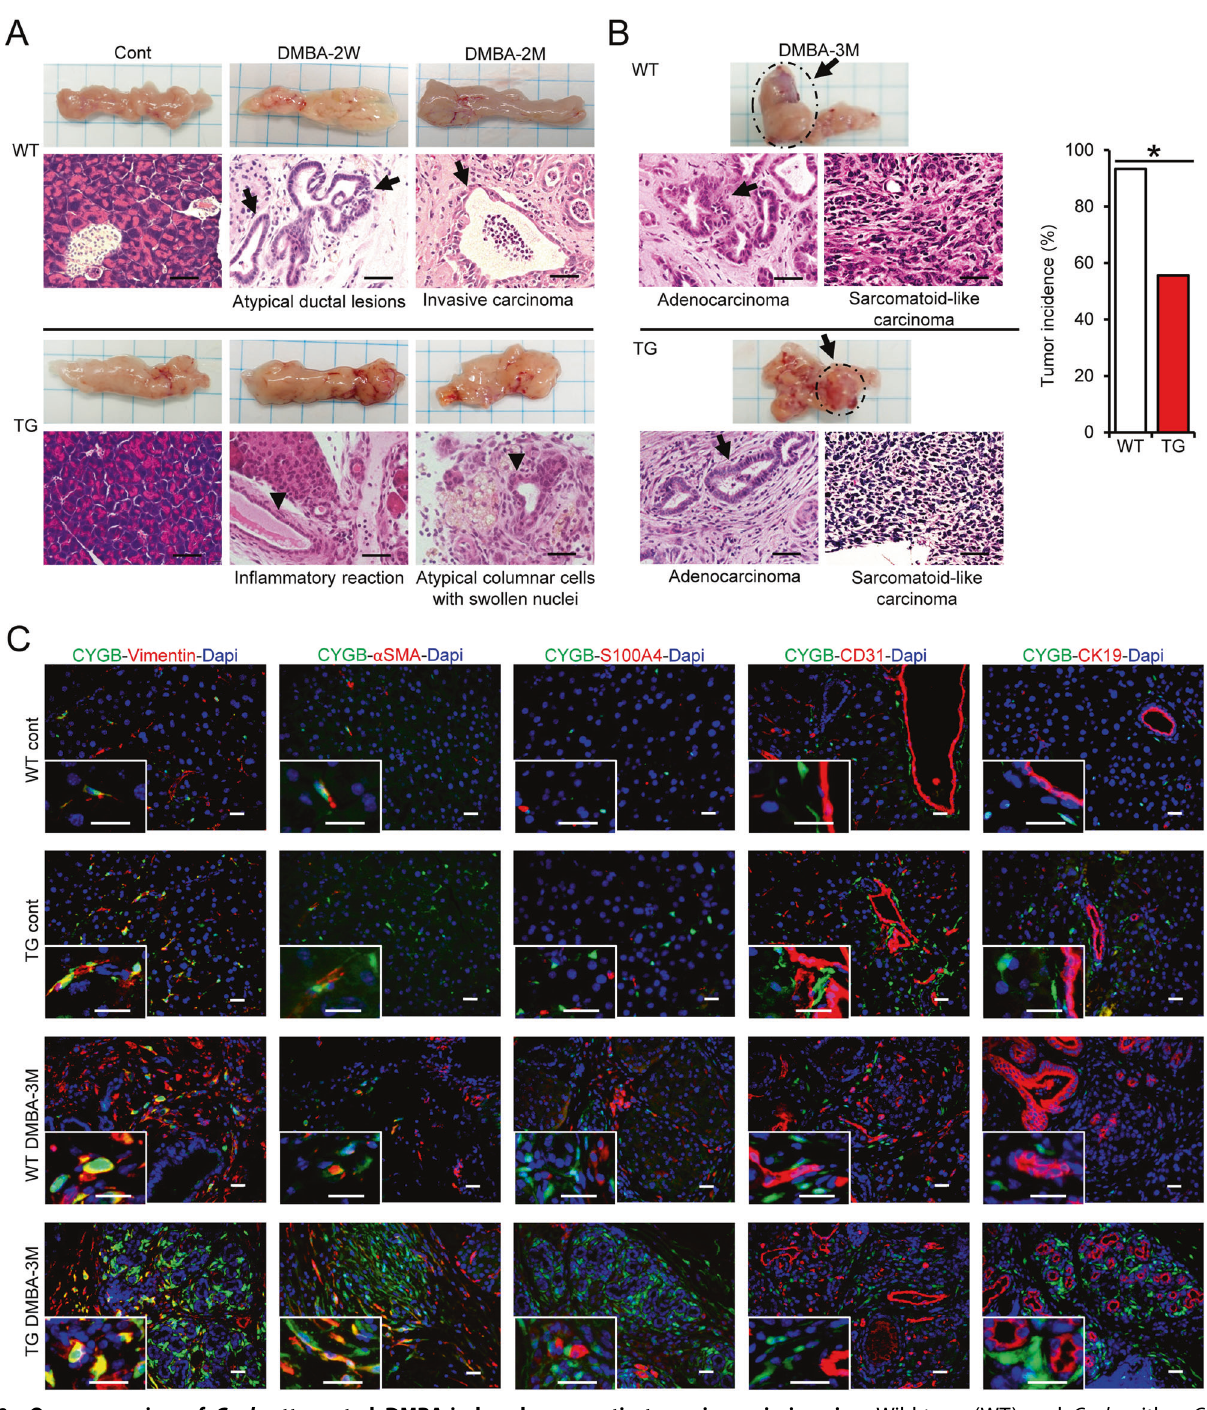
Fig. 2 Overexpression of Cygb attenuated DMBA-induced pancreatic tumorigenesis in mice. Wild-type (WT) and Cygb with mCherry reporter-overexpressing (TG) mice were under placebo (cont) or DMBA treatment at different time-points. A Representative pancreatic macroscopic and microscopic H&E staining images. N = 3 in control groups and n = 8 in DMBA treatment groups. Scale bars, 20 µm. B Representative pancreatic macroscopic and microscopic H&E staining images in 3-month DMBA-treated mice and their tumor incidence. N = 15 in WT group and n = 9 in TG groups Scale bars, 20 µm. * p < 0.05, Fisher ’ s exact test, two-tailed. C Double immuno fl uorescent staining for CYGB (green) and markers for PSCs (Vimentin), activated PSCs ( α SMA), fi broblasts (S100A4), endothelial cells (CD31), and pancreatic ductal cells (CK19) in mouse pancreatic tissues. Dapi was used to visualize nuclei. Scale bars and inset, 20 µm. model. The number of CD68-positive macrophages in pancreatic Attenuation of DMBA-induced pancreatic in fl ammation and fi brosis by Cygb overexpression in mice tissue was lower in DMBA-treated TG mice than in DMBA-treated WT mice at 3 months (Fig. 3A). Compared with DMBA-treated WT As in fl ammatory cells promote PC cell growth and invasion [42], we mice, DMBA-treated TG mice showed lower mRNA levels of CD68, a investigated the in fi ltration of macrophages in our TG mouse Oncogenesis (2022)